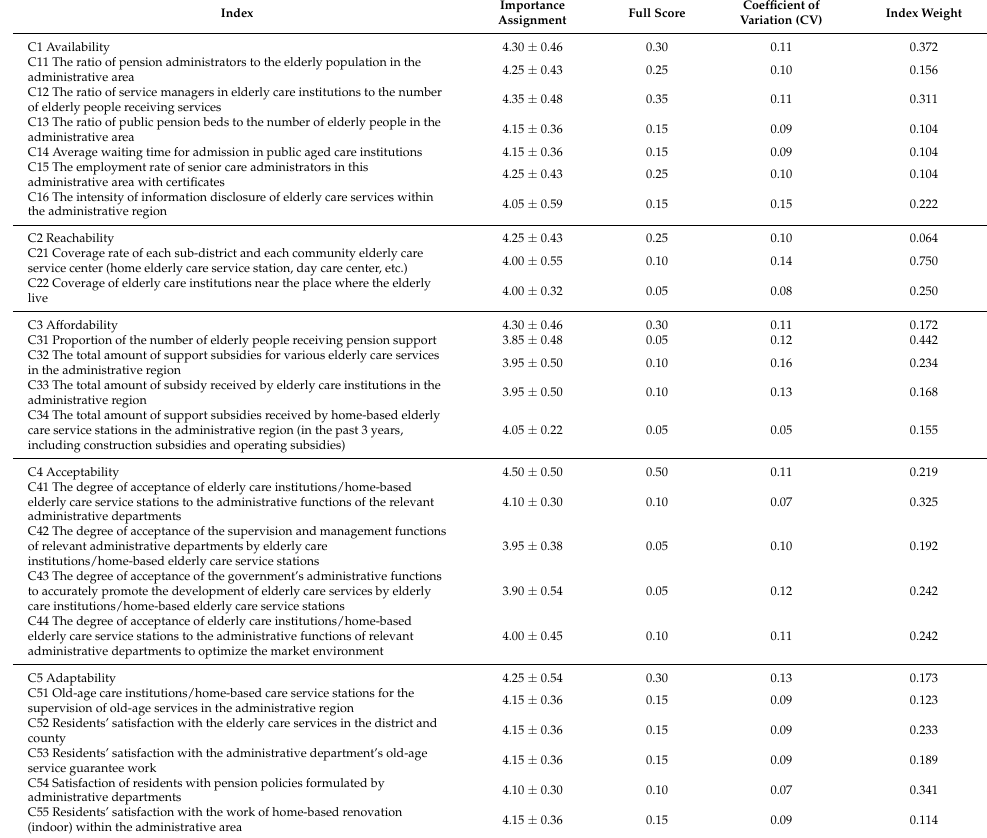
Table 8. Access to administrative